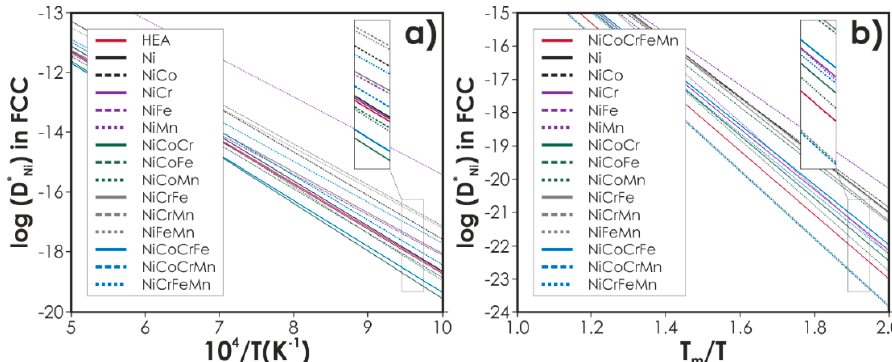
Figure 7. ( a ) Calculated Ni tracer diffusion coefficients vs. the inverse of the absolute temperature, determined at equimolar ratios, ( b ) Calculated Ni tracer diffusion coefficients vs. the inverse of the normalized temperature (after [34]). Reprinted by permission from Springer Nature: Springer, Journal of the Phase Equilibrium and Diffusion, Zhang, C.; Zhang, F.; Jin, K.; Bei, H.; Chen, S.; Cao, W.; Zhu, J.; Lv, D. Understanding of the Elemental Diffusion Behavior in Concentrated Solid Solution Alloys, 2017.